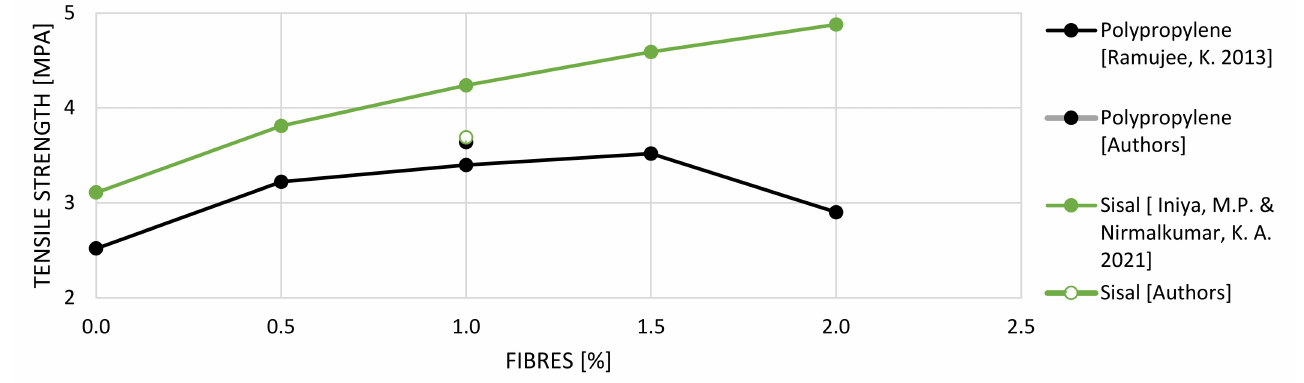
Figure 8. Impact in the tensile strength of different mix designs according to the fiber percentages.